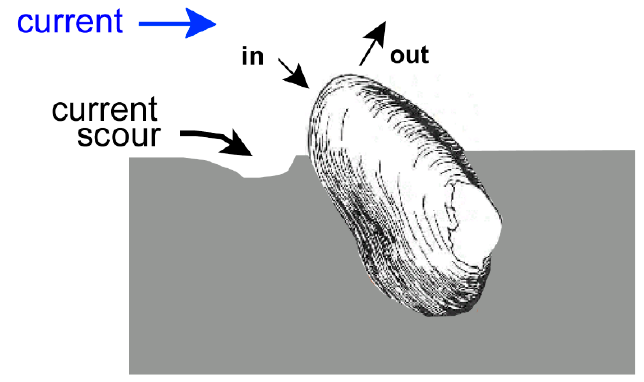
Figure 2. Life position of Archanodon catskillensis . Hinge up, commissure down, shell inclined to sediment water interface so that the posterior remains free of sediment and the inhalant (in) and exhalant (out) siphonal openings are exposed to the flow. After Figure 9 of Chamberlain and Chamberlain [29].